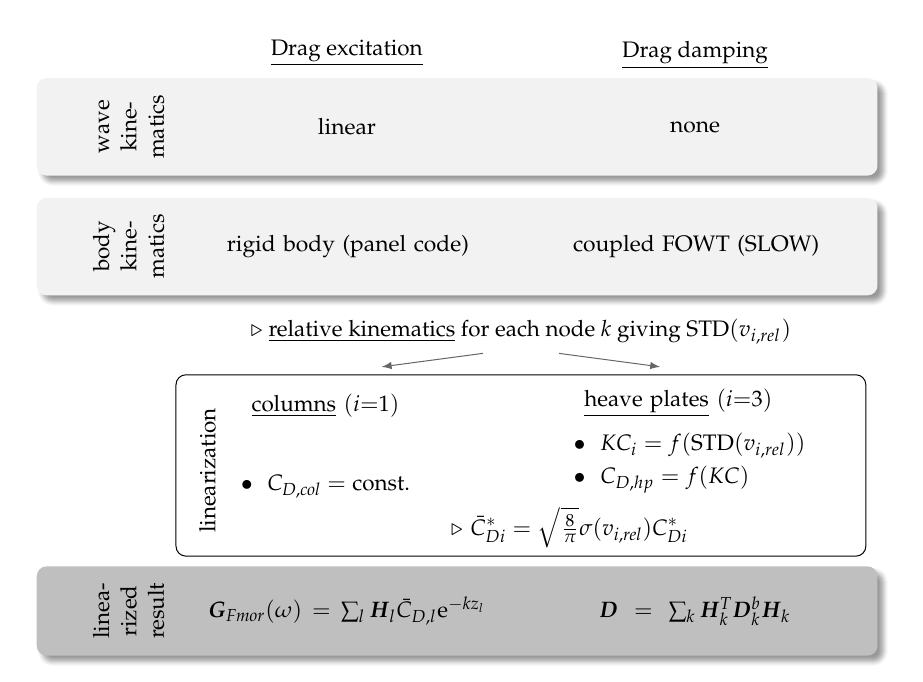
Figure 9. Overview on calculation scheme for Morison drag excitation as well as damping forces as input to linear frequency-domain model. The left column shows the excitation problem, the right column shows the damping problem. The presented approach has distinct procedures for the wave kinematics and the body kinematics. Parametric drag is considered for heave